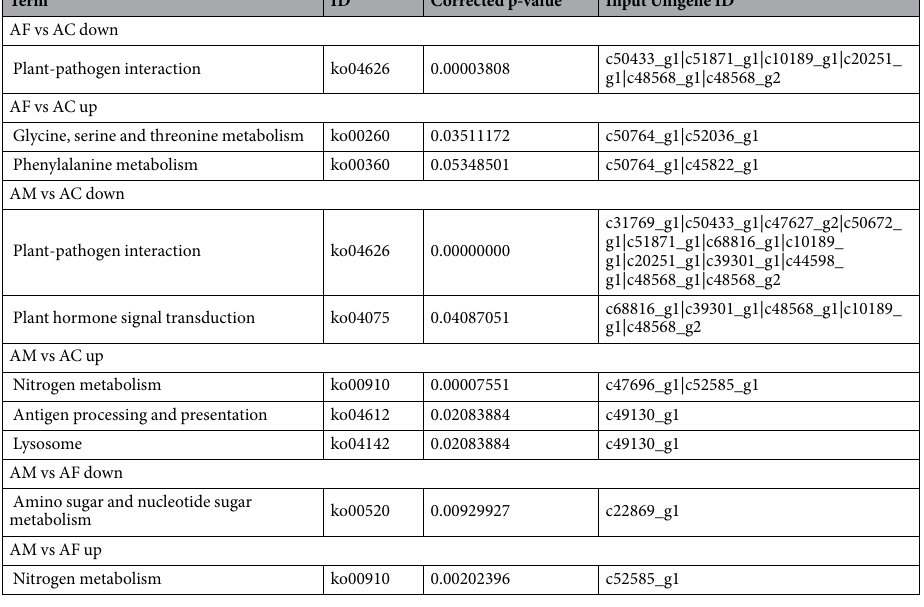
Table 5. KEGG pathway enrichment analysis for